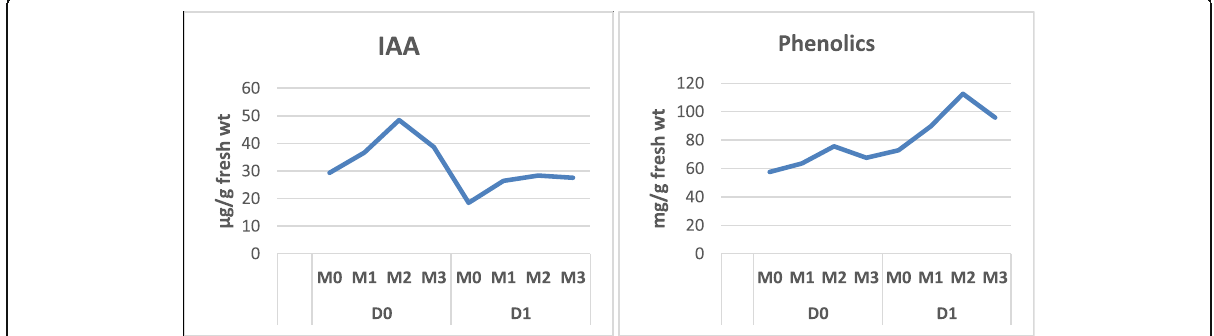
Fig. 2 Effect of melatonin (0, 50, 100, and 150 mM) on indole acetic acid ( μ g/g fresh wt.) and phenolic contents (mg/g fresh wt.) of M. oleifera plants subjected to drought stress (normal irrigation and skipping two irrigation